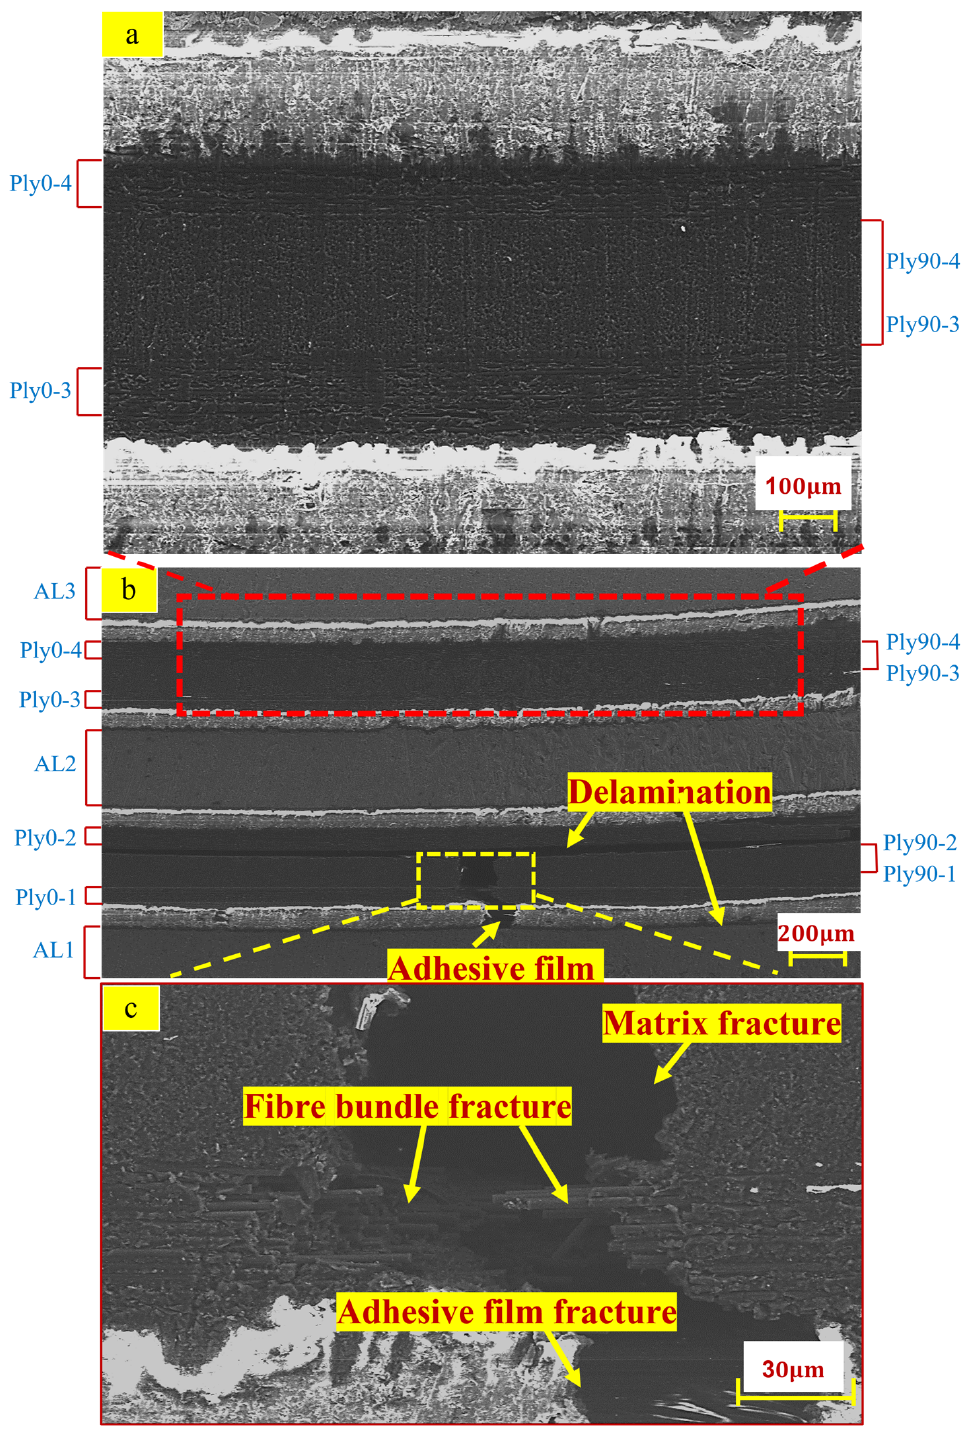
Figure 17. Failure morphology of the three-point bending specimen: ( a ) partially enlarged view above neutral layer; ( b ) overall cross-sectional view; ( c ) partially enlarged view of the failure location below the neutral